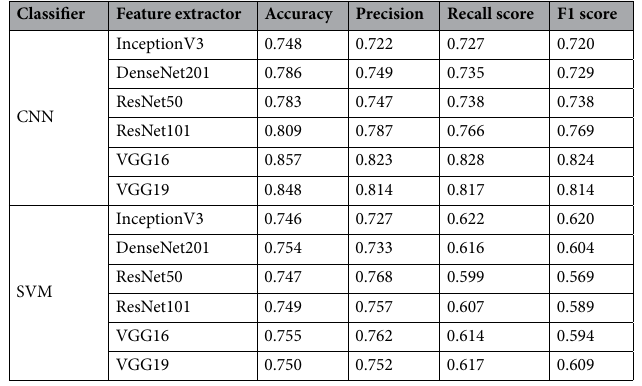
Table 6. Comparison of performance between CNN and SVM with feature extractors (Inception V3, DenseNet201, VGG16).